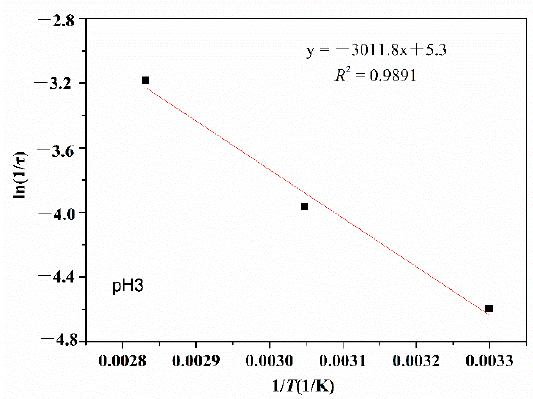
Figure 5. Exponential viscosity decay plots at pH 3.